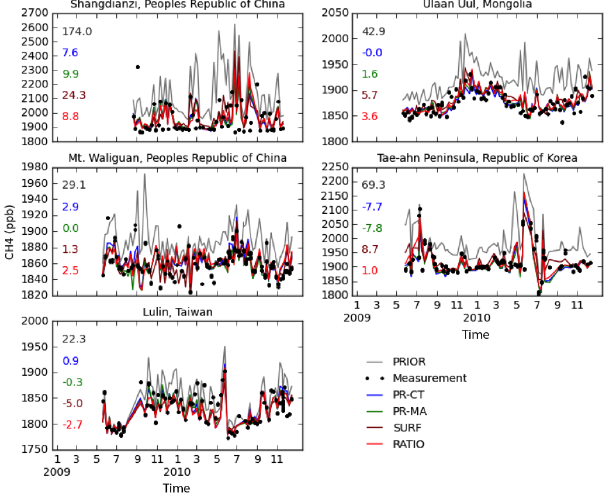
Figure 10. Inversion-optimized fits to surface measurement sites in temperate Eurasia. The numbers in the plots are the mean biases of models with